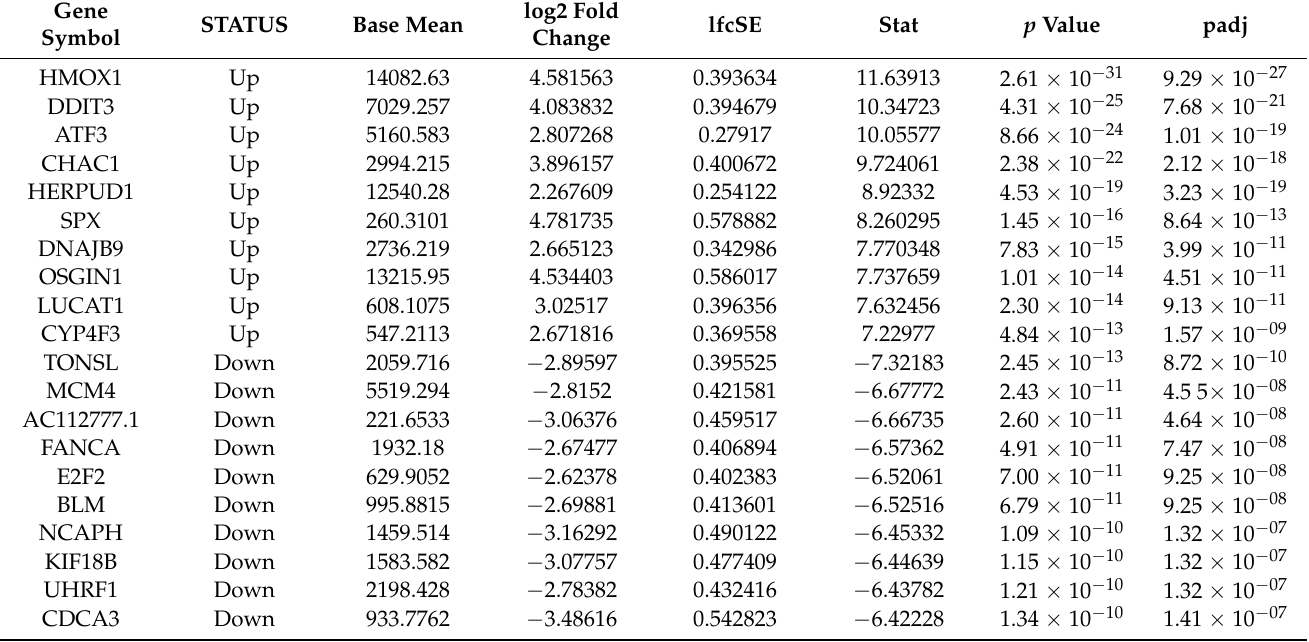
Table 3. The position of 5 CRC-related candidate genes in the PPI network and subnetworks (mod- ules). As shown, CDK1, CCNA2 and BUB1B genes with the highest degree (K) and betweenness (BC) are clustered in subnetwork 1, demonstrating their significant influence in the network. In con- trast, GADD45G and ATF3 genes are classified in clusters 5 and 8, perhaps indicating their inde- pendence to the networks in CRC.